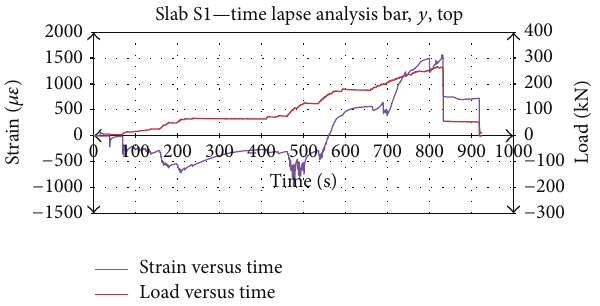
Figure 22: Strain time lapse analysis for gauge 1.3, slab S1.